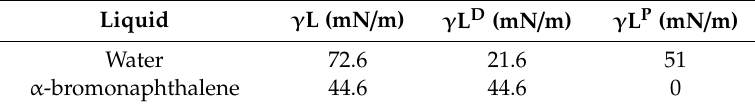
Table 5. Surface tensions of water and α